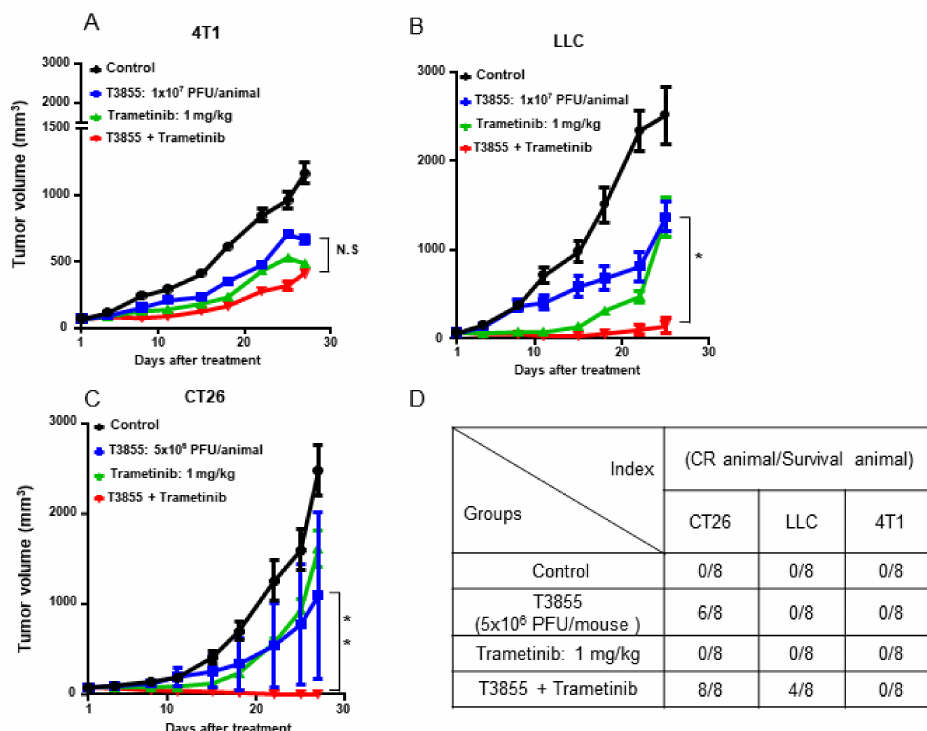
Figure 6. Combined treatment with MEKi Trametinib and oHSV T3855 enhanced antitumor therapeutic activity in LLC and CT26 tumor models. 4T1 (Panel ( A )) or CT26 (Panel ( C )) tumor cells were injected s.c. into the right flanks of Balb/c mice, respectively. LLC (Panel ( B )) tumor cells were injected s.c. into the right flanks of C57BL/6 mice. Different Tumor models averaging 80 mm 3 ( n = 8 per group) were treated via intratumoral injection with PBS or T3855 (1 × 10 7 PFU/animal for 4T1 or LLC; 5 × 10 6 PFU /animal for CT26) on days 1, 8, 15, and 22 and MEKi (trametinib; 1 mg/kg) or vehicle was given from day 1 to 14 via oral gavage. Tumor volumes are shown as mean ± SEM of 8 animals in each group. The complete tumor eradication (Panel ( D )) was summarized at the end of the experiment. N.S. (not significant); p > 0.05, * p < 0.05, ** p <